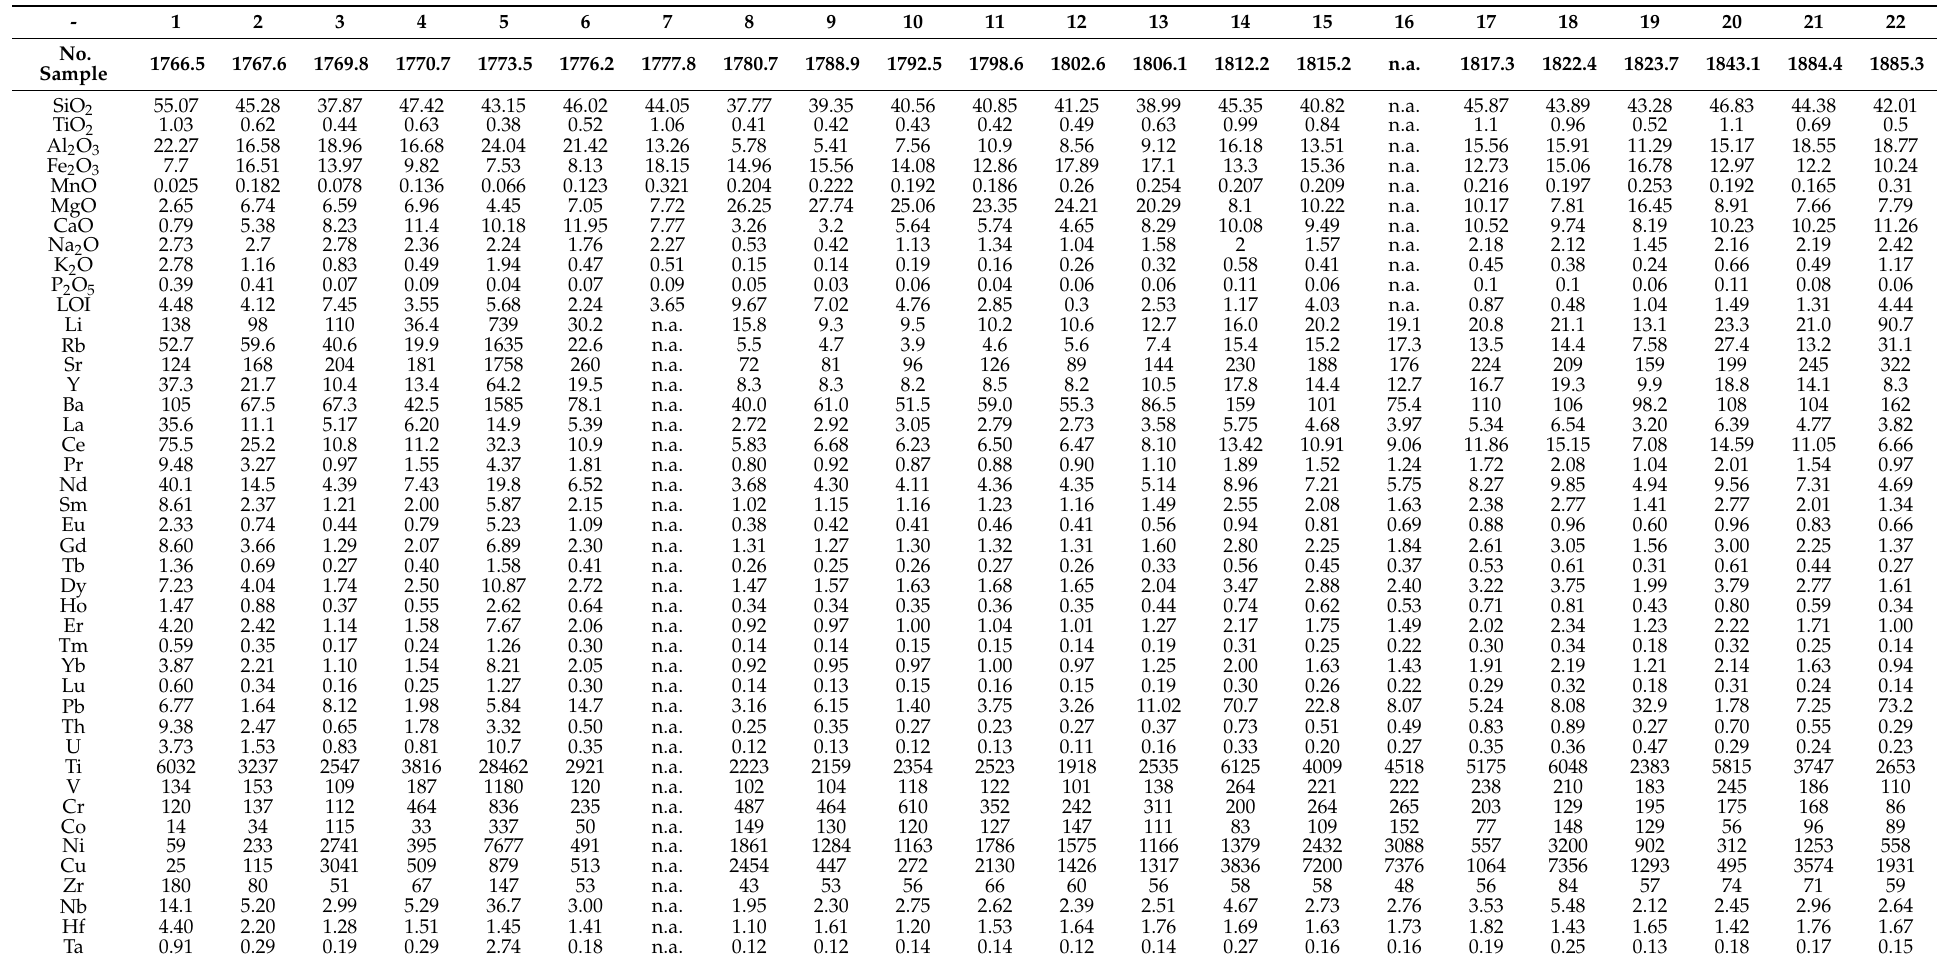
Table 1. Chemical composition of the rocks (borehole RG-2). Oxides are given in wt.%, elements – in ppm; n.a.—element was not analyzed; N sample corresponds to the depth in borehole